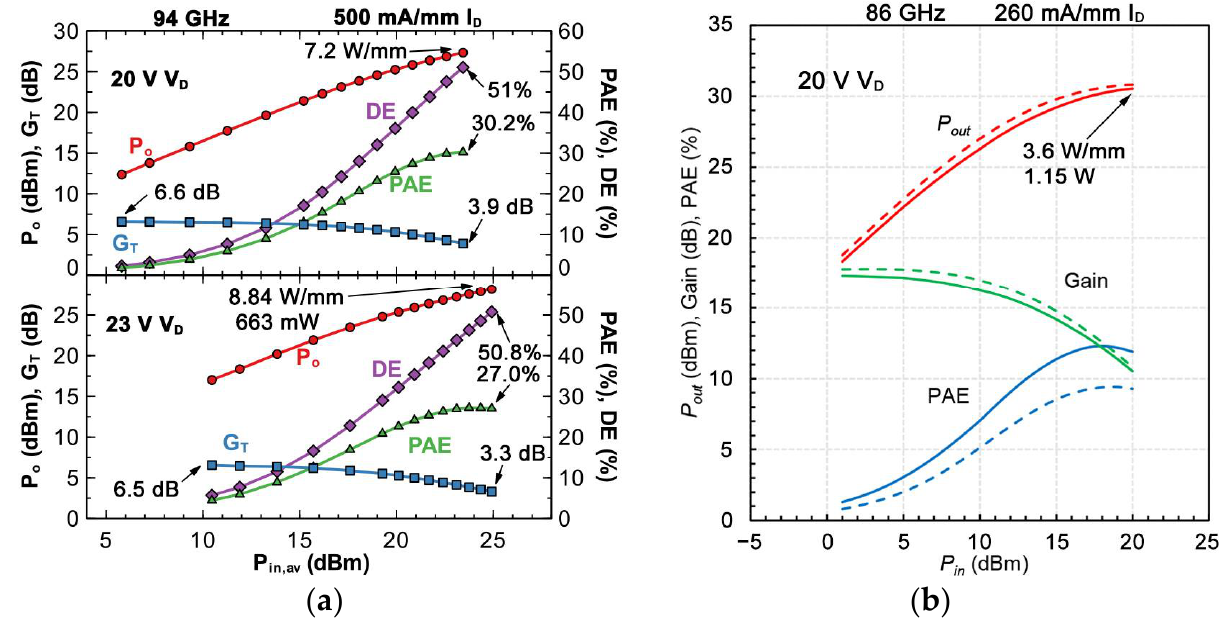
Figure 14. Power characteristics of devices in the W-band. ( a ) NPDR GaN HEMT reported by Romanczyk. Adapted with permission from Ref. [62]. Copyright 2020 by IEEE. ( b ) Advanced Ga-polar MMIC, the solid and dashed lines are the results in the actual measurement and simulation scenarios, respectively. Adapted with permission from Ref. [64]. Copyright 2016 by IEEE.